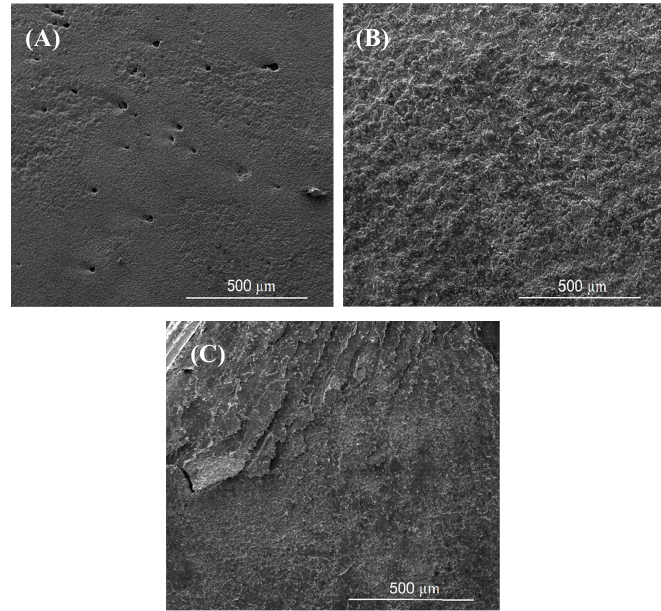
Figure 17. SEM images of the fracture surfaces for joints bonded with pure-Cu for ( A ) 2 min, ( B ) 5 min and ( C ) 10 min.